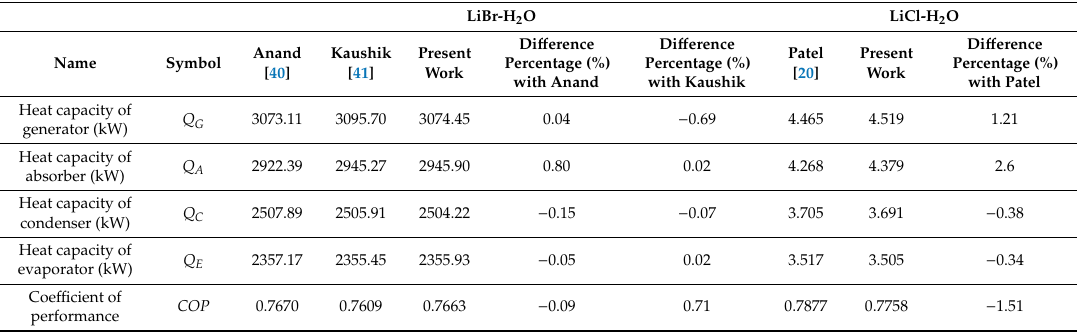
Table 2. Comparisons of energy analysis of present work with references’